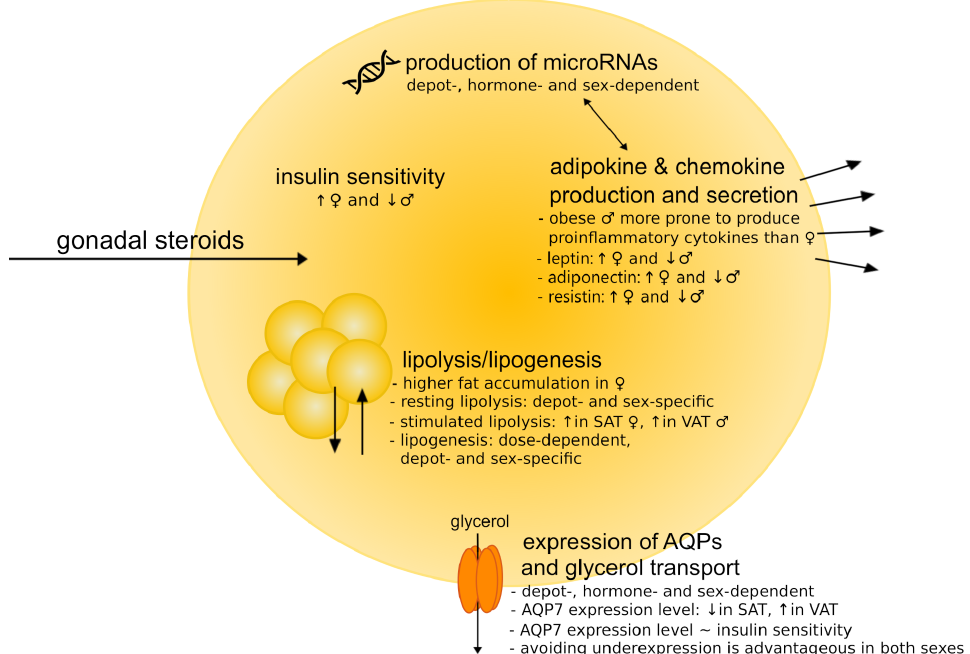
Figure 1. Schematic representation of the most important processes of adipocyte functioning affected by gonadal steroids and the main sex-differences. Sex hormones influence the expression levels of microRNAs, lipolysis and lipogenesis, insulin sensitivity and endocrine function of adipocytes (e.g., adipokine production). One of the most prone connecting links between sex-hormonal imbalance and the disruption of adipose tissue functions is the expression level of aquaporins (AQPs) (in particular, aquaglyceroporins) and, consequently, the effectiveness of the glycerol efflux from